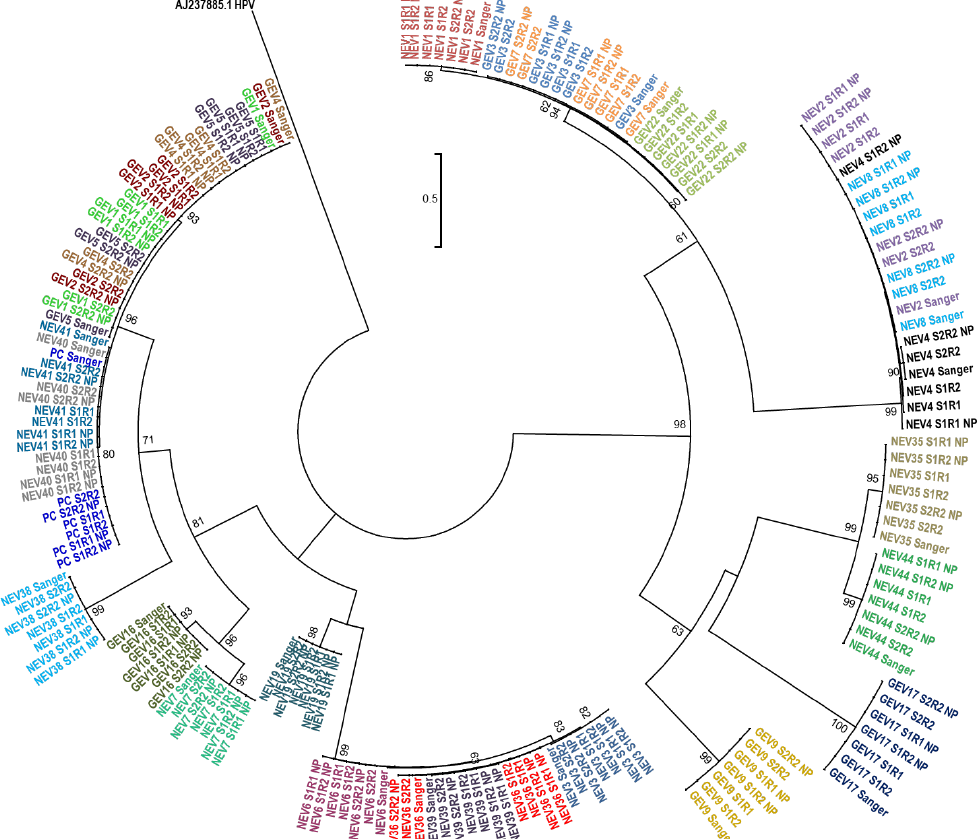
Figure 4. Phylogenetic analysis of all consensus sequences. Nanopore consensus sequences from the two Flongle sequencing runs produced by LORCAN with or without nanopolish correction, and their corresponding Sanger sequences were aligned with MAFFT and subjected to phylogenetic reconstruction. The evolutionary relationships were inferred using the Neighbor-Joining method and the optimal tree with the sum of branch length = 9.910506 is displayed. The percentage of replicate trees in which the associated taxa clustered together in the bootstrap test (1000 replicates) are shown next to the branches. The tree is drawn to scale, with branch lengths in the same units as those of the evolutionary distances used to infer the phylogenetic tree. The evolutionary distances were computed using the maximum composite likelihood method and are in the units of the number of base substitutions per site. The analysis involved 183 nucleotide sequences. All codon positions were included in the analysis, and positions containing gaps and missing data were eliminated, leaving a total of 252 positions (mostly determined by the length of the shorter sequences; Table S3) in the final alignment. Sample ID are abbreviated as follows: S1 = Barcode Set 1, S2 = Barcode Set 2, R1 = Sequencing run 1, R2 = Sequencing run 2, NP = nanopolish . Every sample is colored by sample identity to visualize variability of clustering. The tree was rooted based on the VP1 sequence of human poliovirus 1 (AJ237885.1).